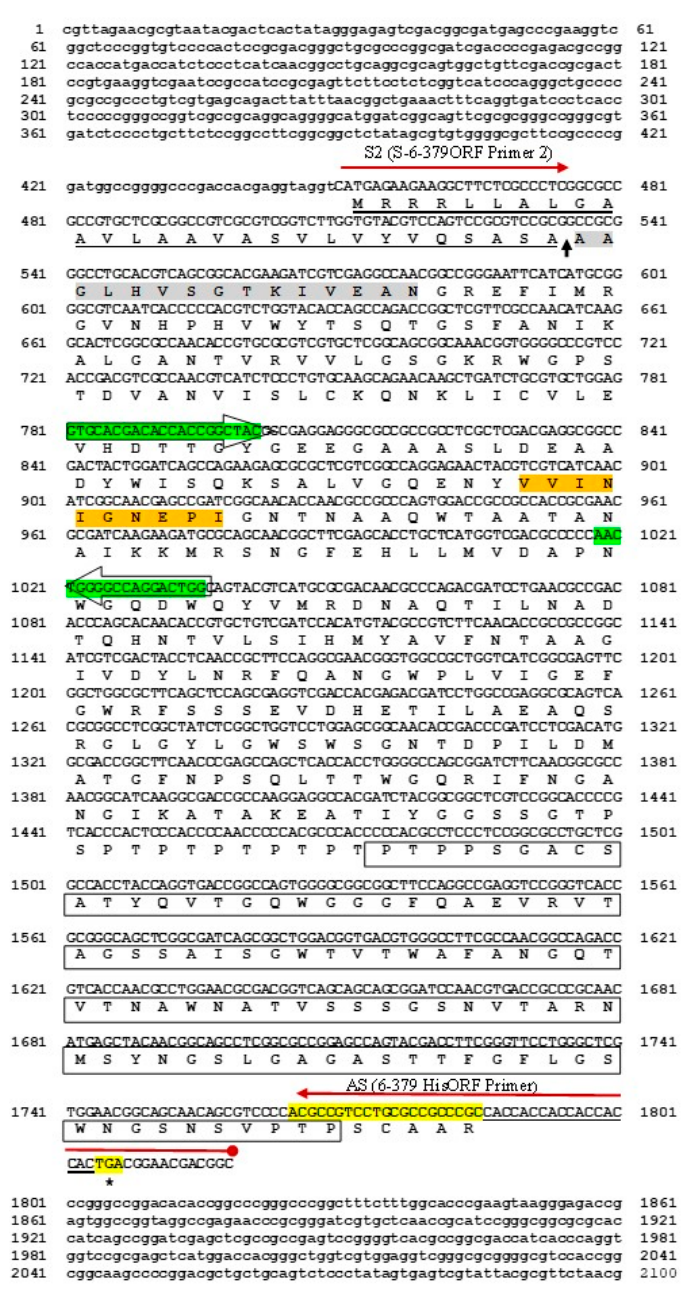
Figure 1. Nucleotide sequence and deduced amino acid sequence of manNj6-379 . The locations of the putative signal peptides (28 amino acids) are underlined. The red arrows indicate the positions of primers used for the cloning of a probable mature mannanase, with a 6x His tag for purification. The N-terminal amino acids of mature mannanase (15 amino acids) verified by protein sequence are shown in the shaded boxes. Green arrow boxes indicate the position of a pair of primers used for isolation of partial mannanase genes from the whole genome of N. jabiensis ID06-379. The conserved region of the glycosyl hydrolase family 5 signature is indicated by the orange shading. The deduced ManNj6-379 is suggested to contain a CBM 2 at residues 360–440 (shown in boxes), and the two tryptophan residues involved in cellulose binding are shaded and in bold caps. The transcriptional stop codon is indicated by an asterisk ( * ).